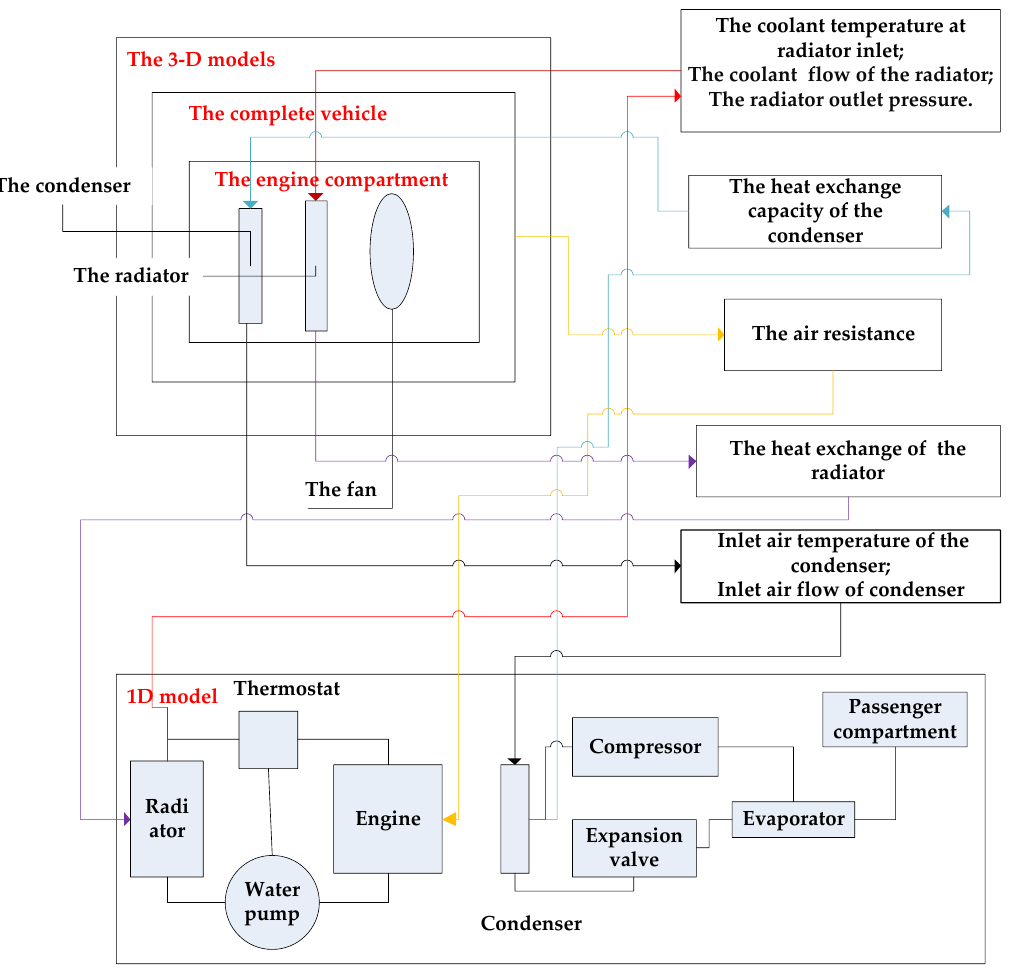
Figure 3. Schematic diagram of data transmission.